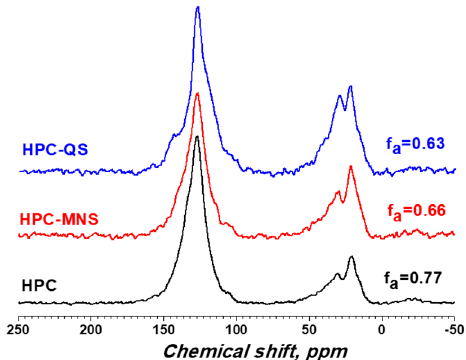
Figure 1. 13 C-NMR spectra of HPC, HPC-MNS and HPC-QS.